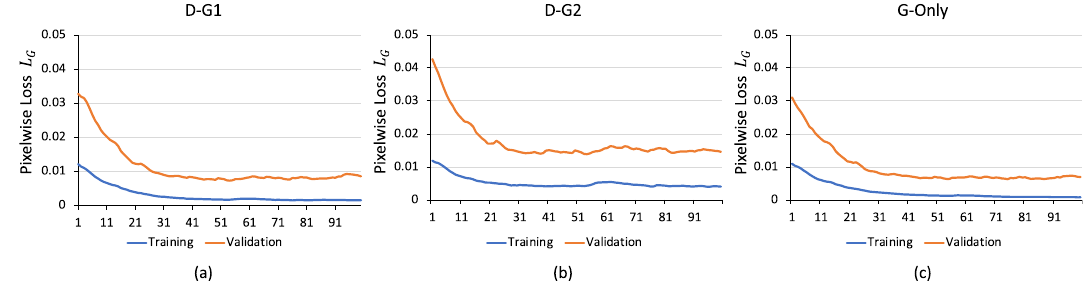
Figure 9. The L G training and validation loss for ( a ) D-G1, ( b ) D-G2, and ( c ) G-Only training approaches. L G represents the pixelwise loss between the generated image and the ground truth. The L G converged to different values according to the training approaches. The G-Only has the lowest L G validation loss whereas the D-G2 has the highest